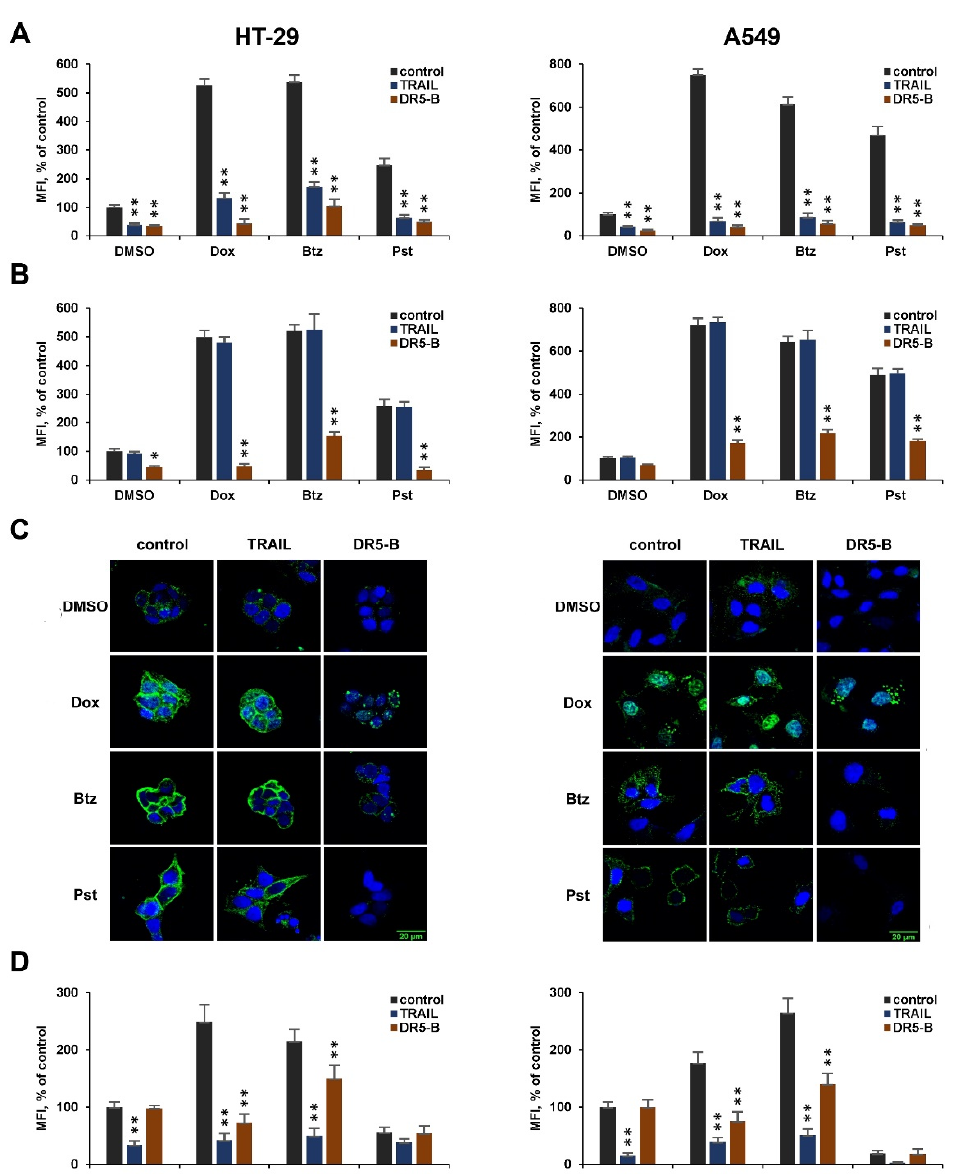
Figure 3. DR5-B causes internalization of DR5 more efficiently than TRAIL. Cells were treated with doxorubicin (4000 nM), bortezomib (200 nM) or panobinostat (400 nM) or with appropriate volumes of dimethyl sulfoxide (DMSO) as a control for 24 h, followed by incubation with TRAIL or DR5-B at a concentration of 1000 ng / mL ( A ) or 10 ng / mL ( B ) for 1 h. Surface expression of DR5 was determined by flow cytometry. Representative histograms from three independent experiments with similar results are shown. ( C ) Cells seeded on a glass slide were treated with chemotherapeutic agents for 24 h, followed by incubation with 10 ng / mL ligands for 1 h. Immunofluorescence staining of the DR5 receptor was analyzed by confocal LSM. ( D ) Surface expression of the DR4 receptor was determined by flow cytometry after treatment of cells with chemotherapy for 24 h, followed by incubation of 1000 ng / mL of ligands for 1 h. Mean ± Standard Deviation ( n = 3). The asterisks indicate significance (* p < 0.05) and (** p < 0.001) relative to cells treated with chemotherapy without